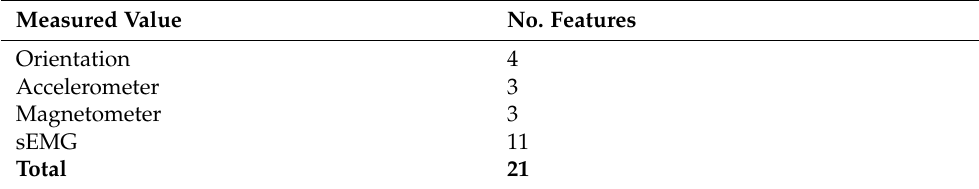
Table 1. Breakdown of the number of features used from each sensing input available. Measured